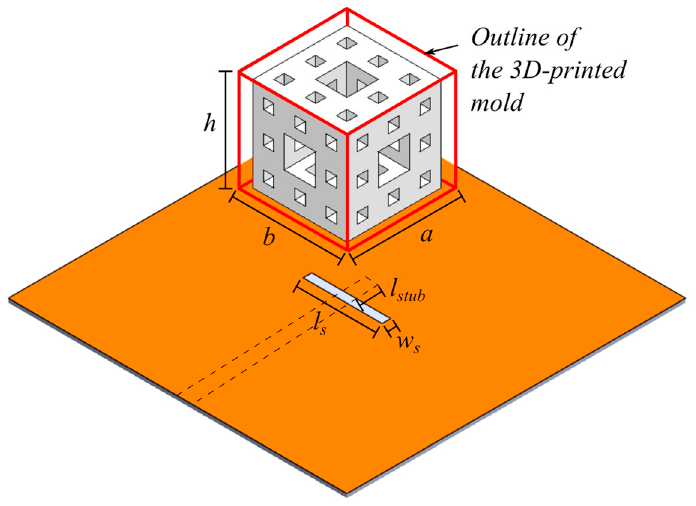
Figure 5. Sketch of the menger sponge fractal DRA in its second iteration The DRA is enclosed by a mold, indicated by the red, solid lines surrounding the DRA. The mold controls the shape of the dielectric paste, which is filled inside and depicted in white color. The DRA has a length, width, and height of a , b , h , respectively. The structure is accommodated by a feeding slot of length and width l s and w s and is backed by a microstrip line with width w strip , which extends the slot by a length l stub.